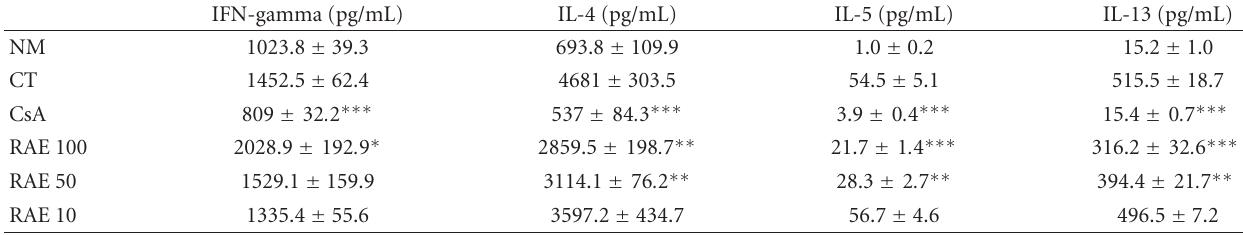
Table 1: E ff ects of RAE on cytokines in CD4 + t cells isolated from Naive C57bl/6 Mice (NM: Normal C57BL/6 mice; CT: a-CD3/CD28 + CD4 + T cells; CsA: a-CD3/CD28 + CD4 + T cells + CsA; RAE 100: a-CD3/CD28 + CD4 + T cells + RAE (100 μ g/mL); RAE 50 : a-CD3/CD28 +